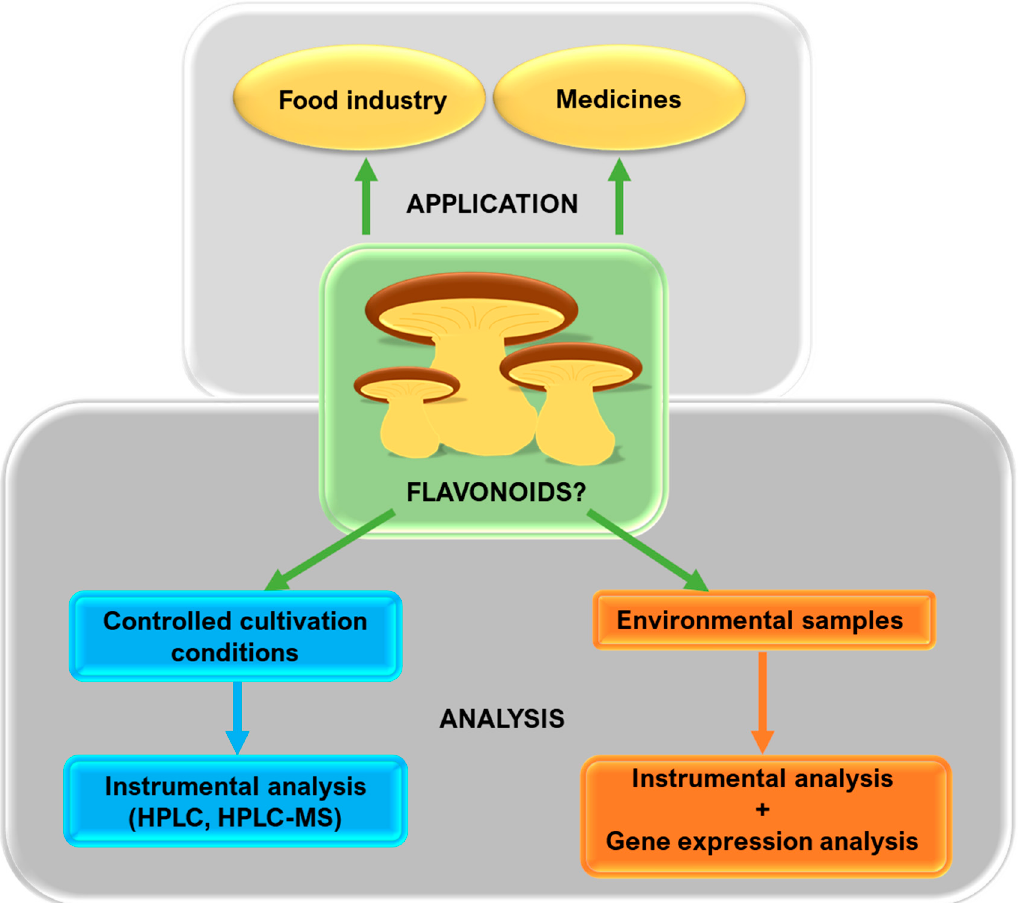
Figure 2. Proposed scheme of experiment selection for different specimens.